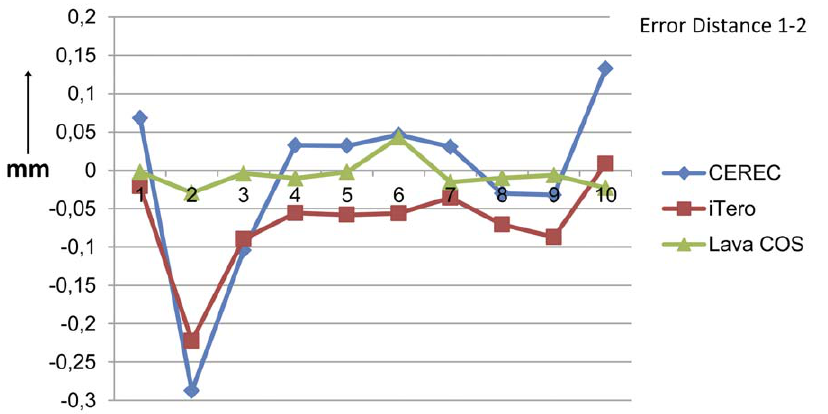
Figure 6. The distance errors between the cylinders 1 and 2 in millimeters for the three intra-oral scanners. The smallest distance error between cylinders 1 and 2 was 2 22,0 m m (Lava COS), while the largest error was 2 287,5 m m (CEREC). The Lava COS scanner showed the smallest mean distance error and also showed the smallest variations.